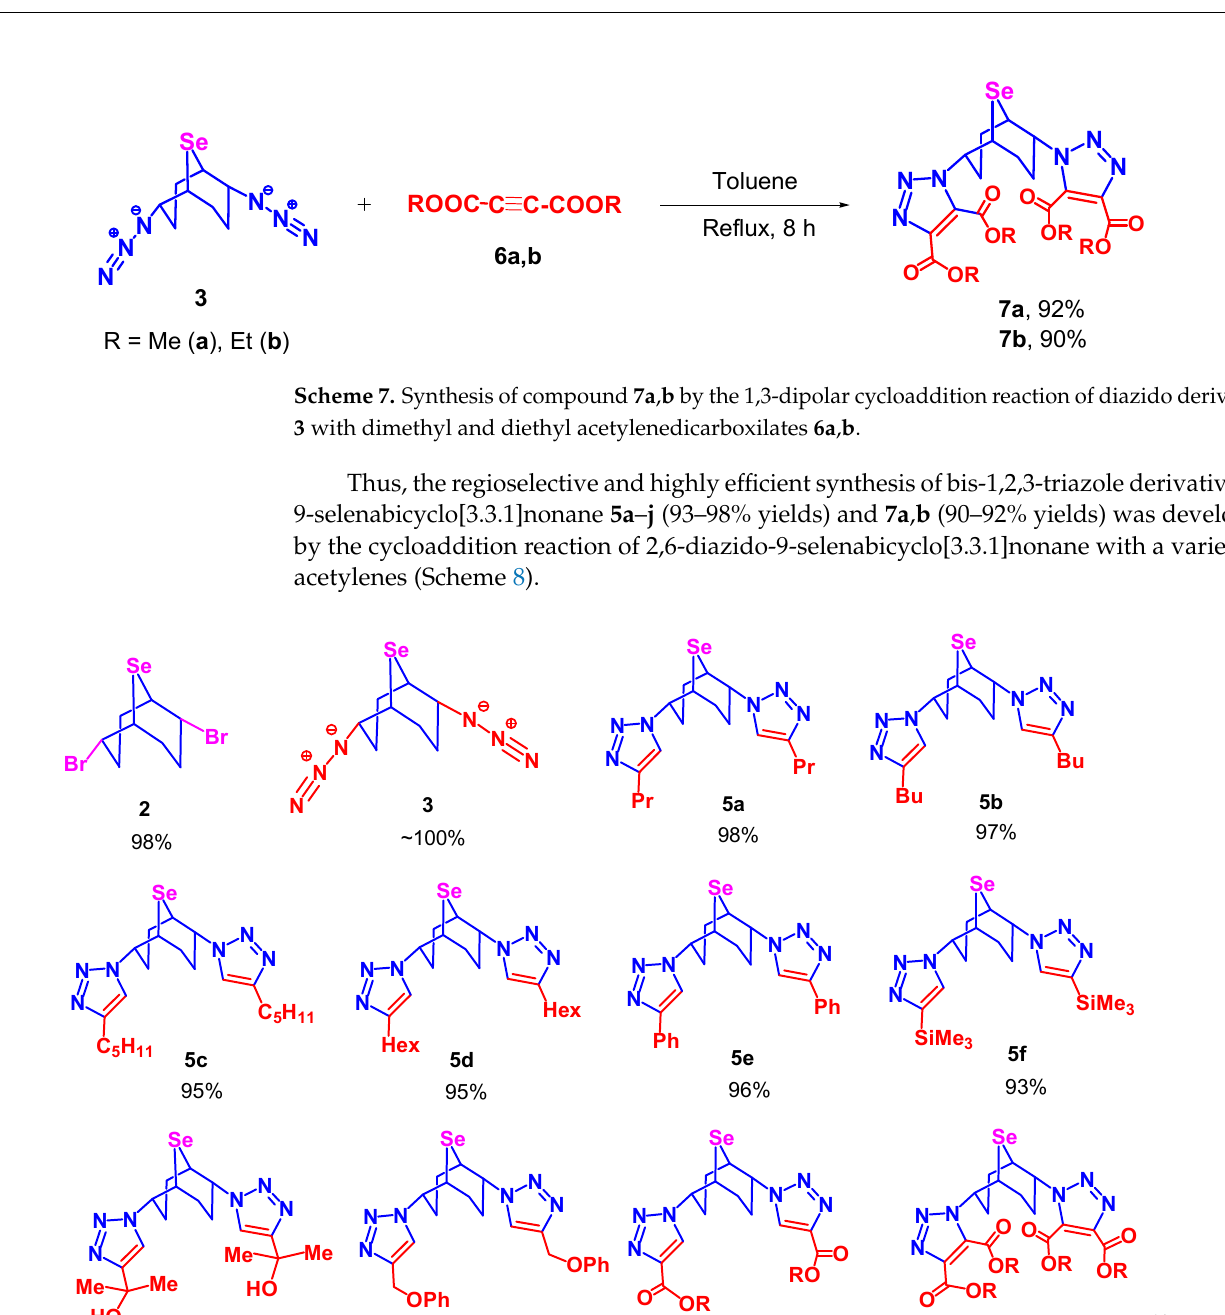
Scheme 8. The obtained products 2 , 3 , 5a – j , and 7a , b .